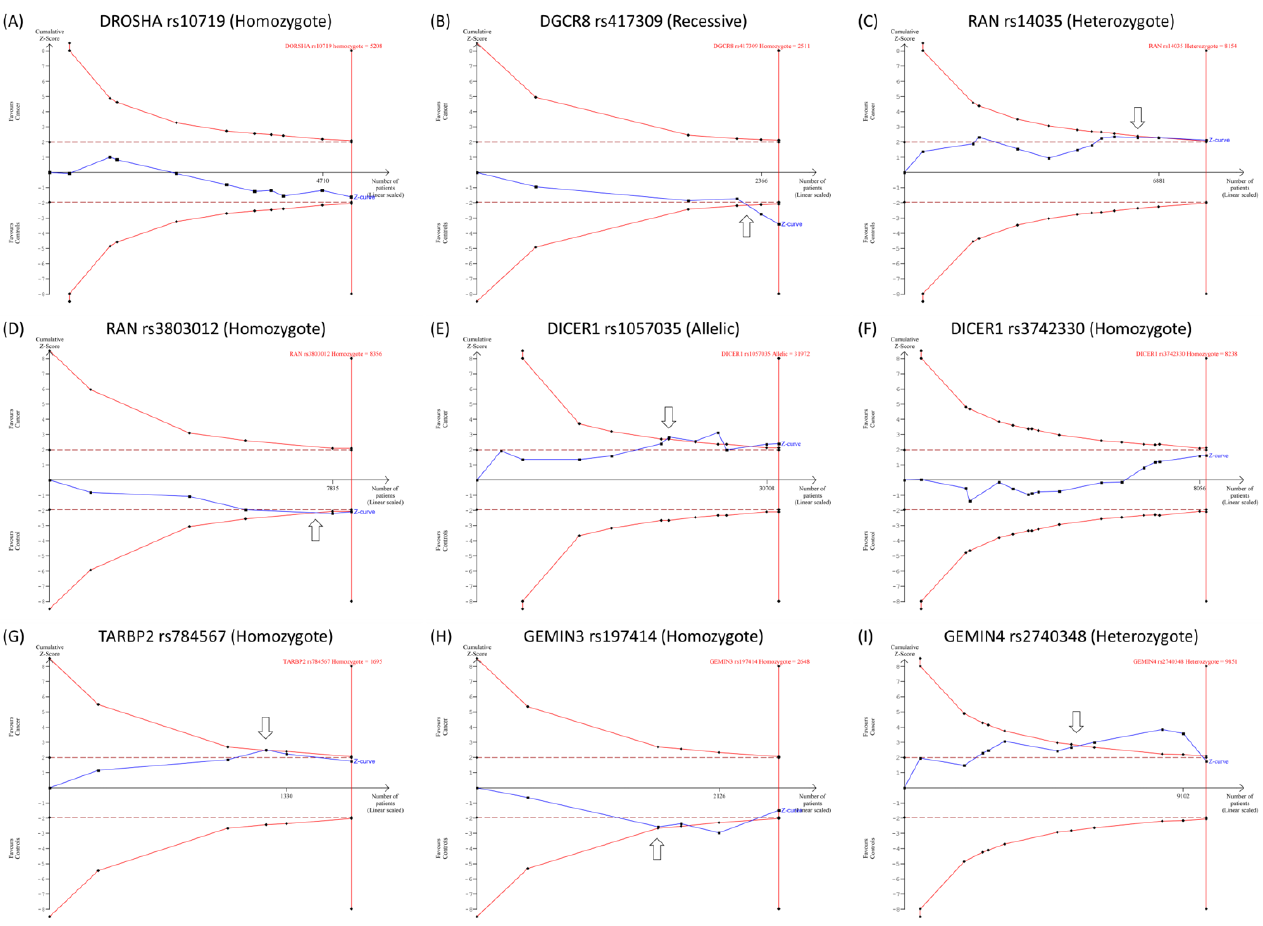
Figure 5. Trial sequential analysis (TSA) for gene polymorphisms. Variants with ten studies or